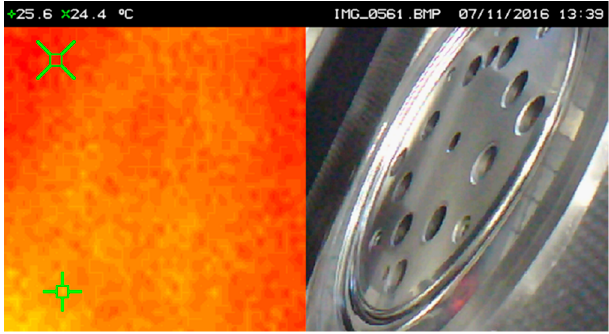
Figure 16. Temperature developed in the TiAlN-coated pressure ring obtained by thermography. In the ( left ) image, the thermograph image corresponding to the tool surface shown in the picture ( right ).